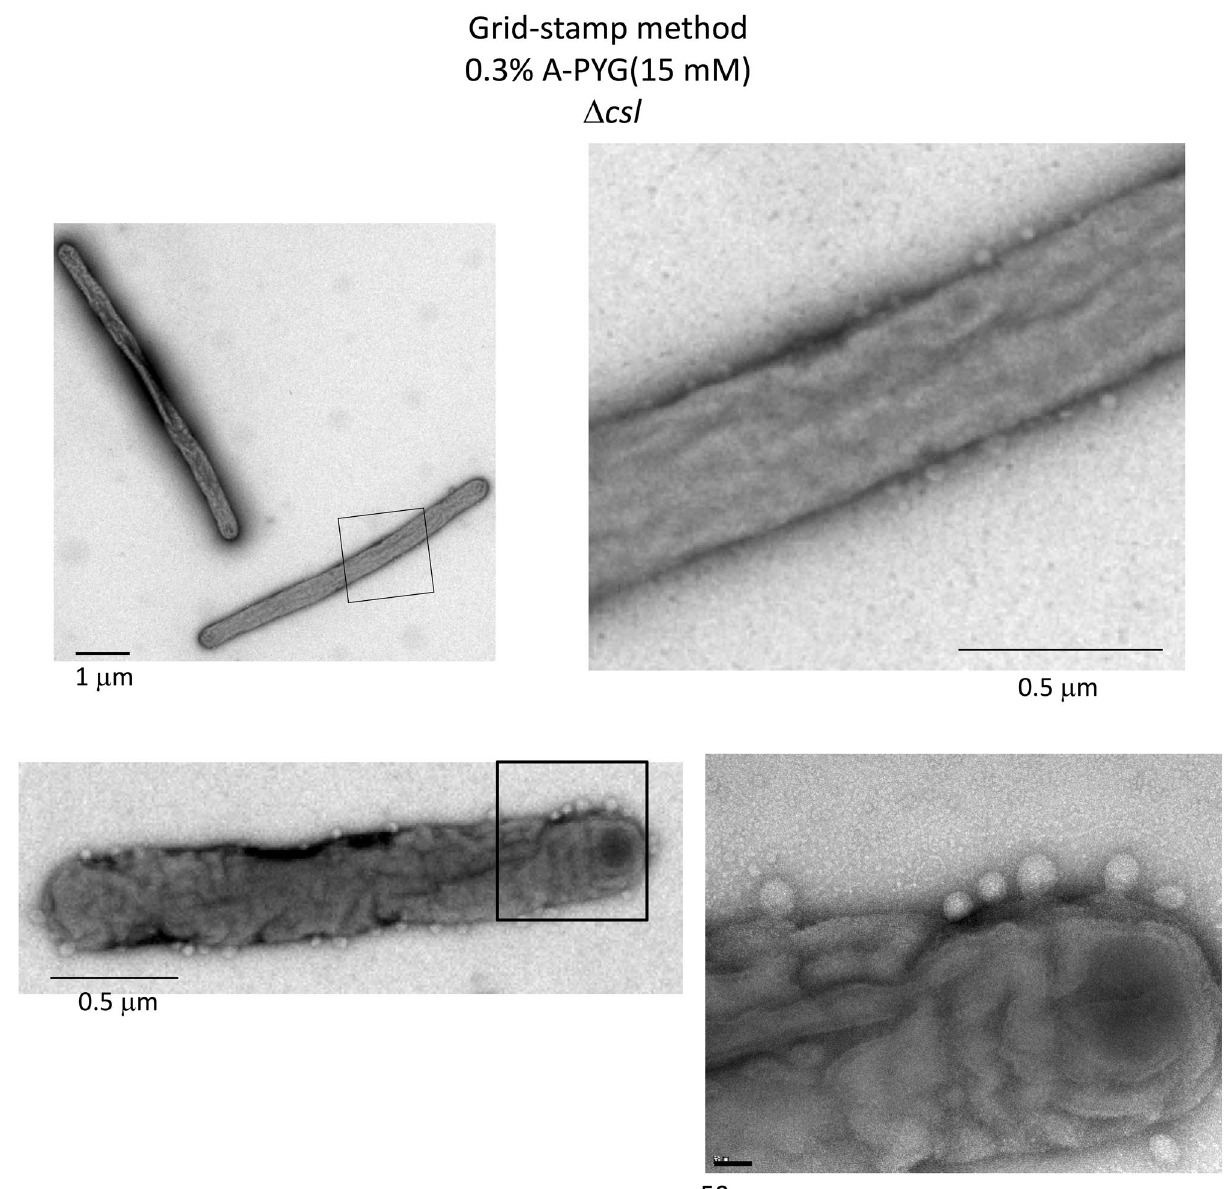
Figure 8. Grid stamp images of the edge of Δcsl mutant F. johnsoniae spreading colonies on 0.3% A-PYG (15 mM). Left: grid-stamp images of bacteria in the spreading front region. Right: high magnification image of the squares indicated in the left panels. Many vesicles were released from the Δcsl cells. The dark spots of high electron density observed in the WT cells on 1% A-PY2 28 were not observed in Δcsl cells on 0.3% A-PYG (15